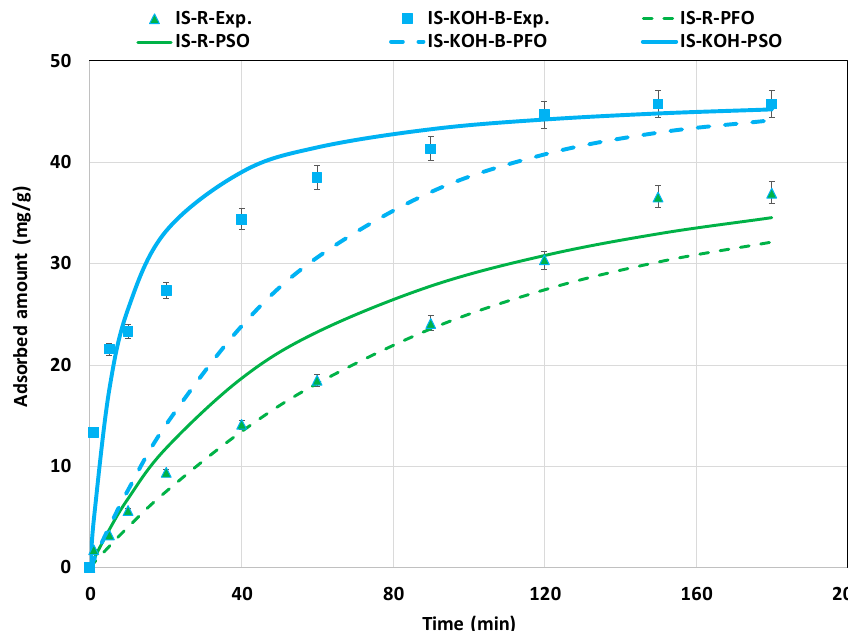
Figure 3. MB adsorption kinetic by IS-R and IS-KOH-B and its fitting with PFO and PSO kinetic models (C0 = 50 mg L − 1 ; adsorbent dose = 1 g L − 1 ; natural pH; T = 20 ± 2 °C).